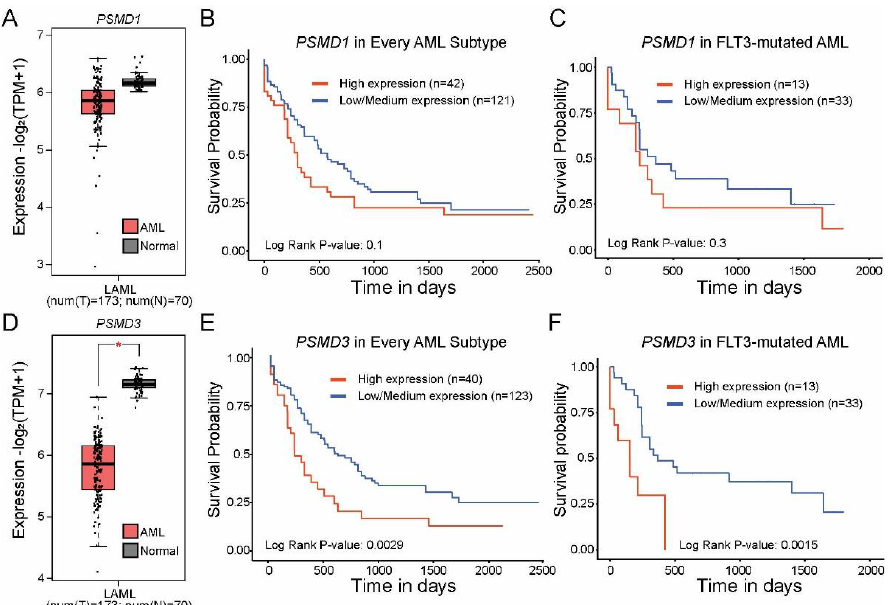
Figure 1. High levels of PSMD3 but not PSMD1 mRNA expression correlated with worse overall survival (OS) in FLT3-mutated AML. ( A ) The box plot shows PSMD1 expression in AML versus normal mononuclear cells (MNCs) from GEPIA2. Error bars represent standard error of the mean (SEM, p = ns). ( B , C ) Kaplan – Meier curves show the effect of PSMD1 mRNA expression on OS in AML when all subtypes are considered ( B ) and in FLT3-mutated AML ( C ) from UALCAN. ( D ) The box plot shows PSMD3 expression in AML versus normal MNCs from GEPIA2. Error bars represent SEM (* p < 0.001). ( E , F ) Kaplan – Meier curves show the effect of PSMD3 mRNA expression on OS in AML when all subtypes are considered ( E ) and in FLT3-mutated AML ( F ) from UALCAN.